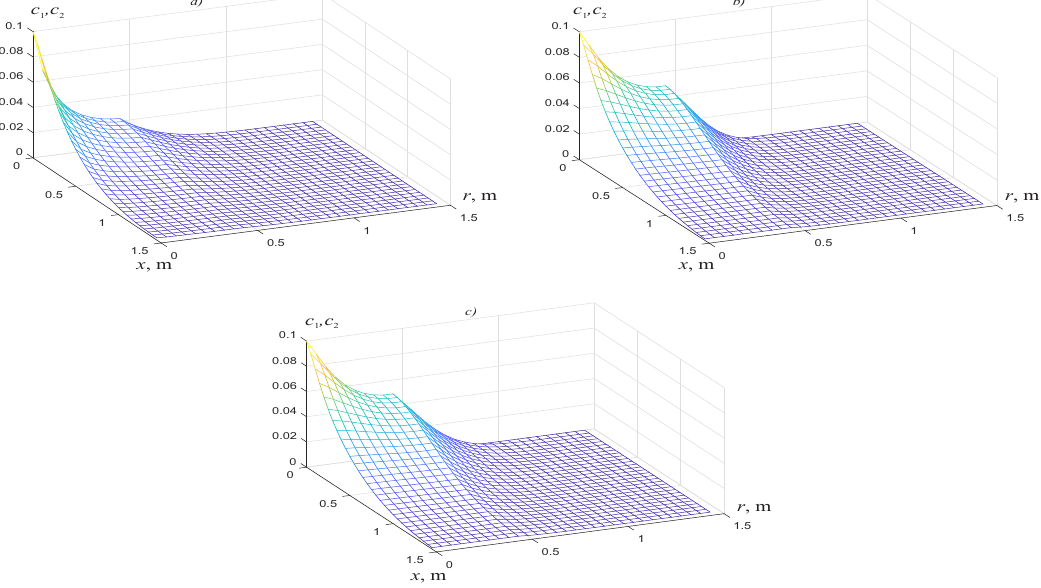
= 2, γ = 1, D = 5 · 10 − 5 m γ ∗ 1 /s, 2 1 x 1 = 2 ( a ), γ ∗ = 1.8 ( b ), γ ∗ = 1.6 ( c ) 2 2 2